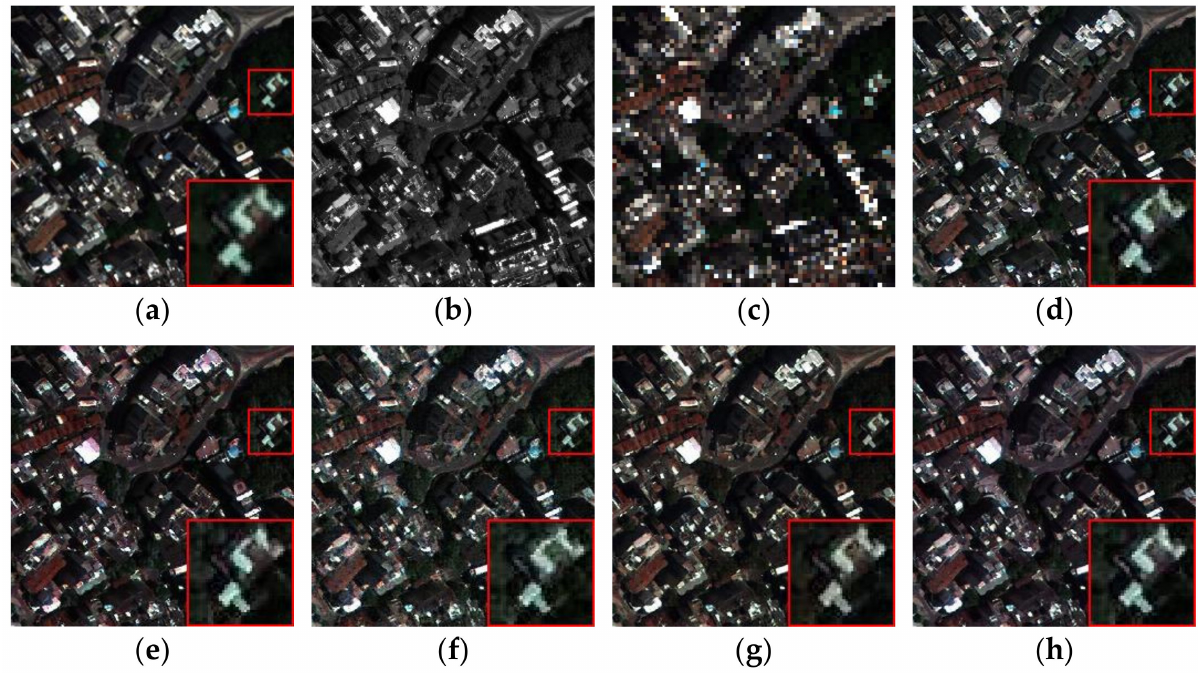
Figure 15. Network generalisation capabilities tested on WorldView3 (( d – h ) are trained on QuickBird). ( a ) Reference image; ( b ) PAN; ( c ) LRMS; ( d ) DMDNet; ( e ) CPNet; ( f ) TPNwFB; ( g ) TDPNet; ( h ) our